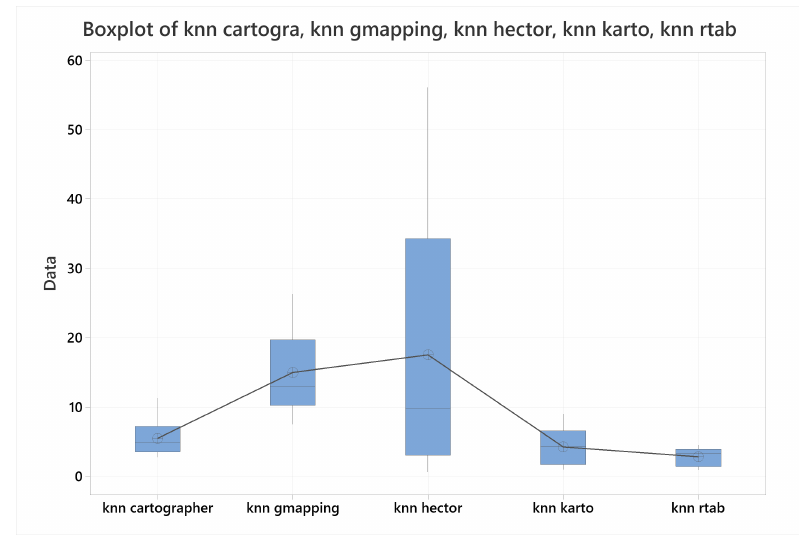
Figure 31. Boxplot for map accuracy with all the algorithms together. The data used for this section can be referenced in the Table 12. Table 12. Observation means for map